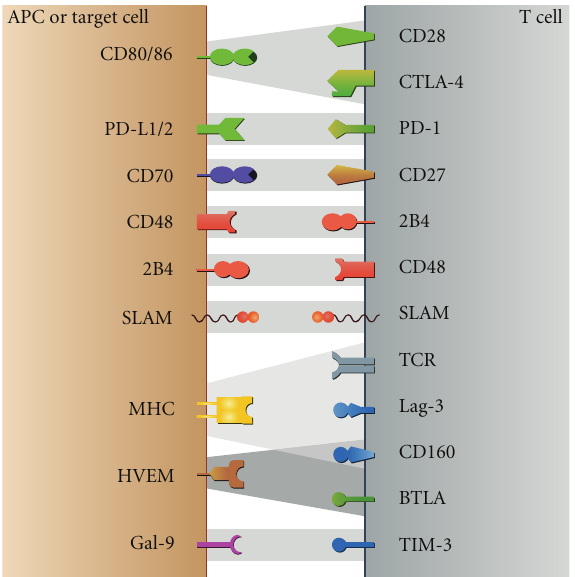
Figure 1: Regulatory molecules and their ligands. Schematic overview of the di ff erent costimulatory and coinhibitory molecules expressed by T cells (right panel) and association with their respective ligands expressed by antigen-presenting cells (APCs) or target cells (left panel). Coinhibitory molecules are color coded according to their relevant families. The four families of regula- tory molecules include (1) B7-CD28 family including CD28, cytotoxic T-lymphocyte antigen-4 (CTLA-4; CD152), programmed death-1 (PD-1; CD279), inducible costimulatory molecule (ICOS; CD278), and B- and T-lymphocyte attenuator (BTLA; CD272); (2) CD2/signaling lymphocyte activation molecule (SLAM) family including SLAM (CD150), 2B4 (CD244), and CD48; (3) Ig family including T-cell immunoglobulin mucin-3 (TIM-3), CD160, and Lymphocyte-activation gene 3 (Lag-3); and (4) TNF-receptor superfamily including